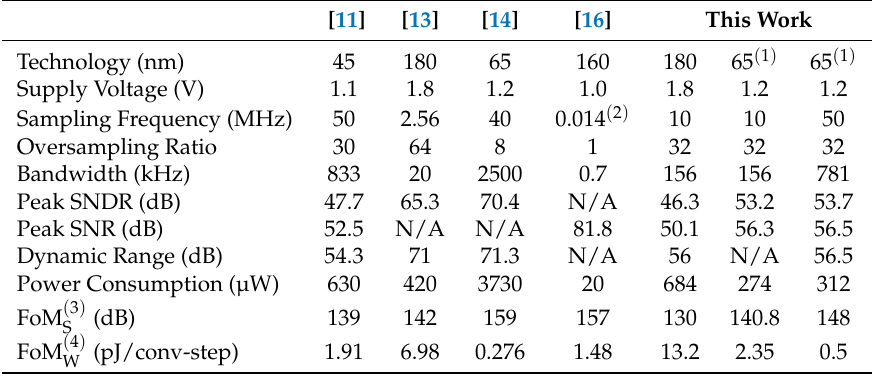
Table 3. Performance comparison with other